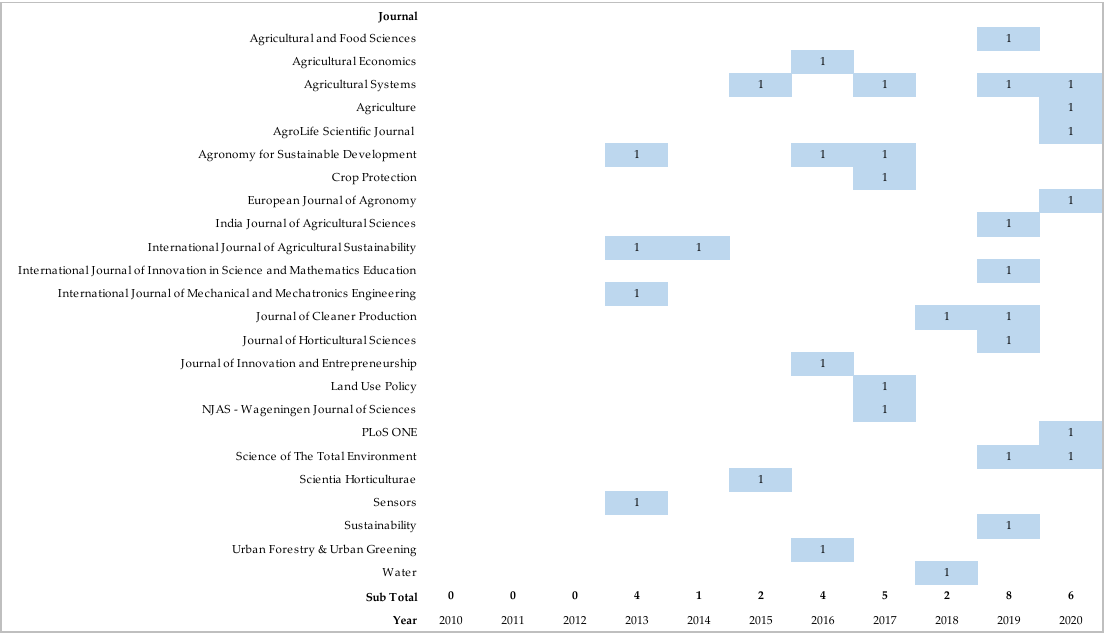
Figure 3. Number of papers per journal and per year. (Source: our elaboration.)